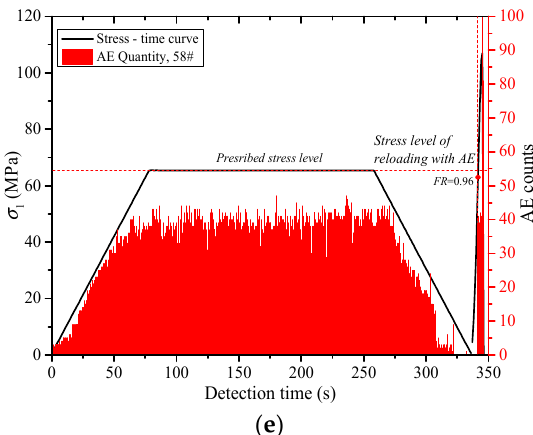
Figure 8. Stress–time–AE curves in uniaxial cyclic loading and unloading test of marble under different loading rates ( σ A = 0.7 σ c ). ( a ) l r = 0.001 mm/s; ( b ) l r = 0.005 mm/s; ( c ) l r = 0.01 mm/s; ( d ) l r = 0.05 mm/s; ( e ) l r = 0.1 mm/s.